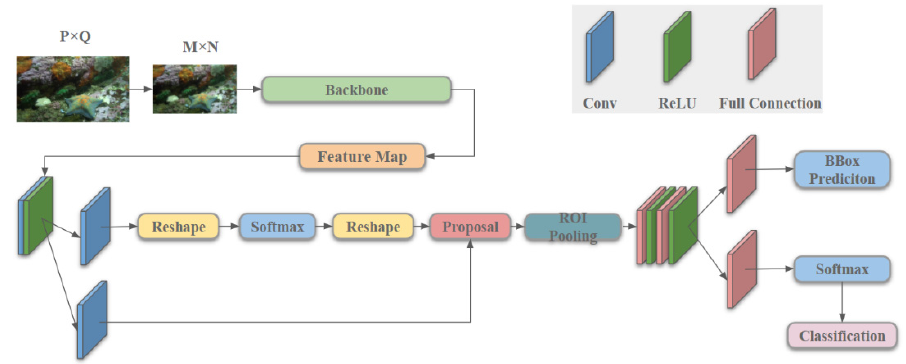
Figure 1. Overall structure of Faster-RCNN.